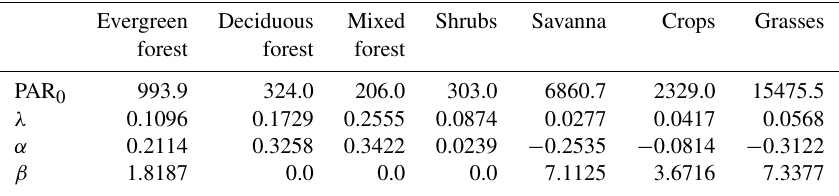
Table A1. VPRM parameters used within WRF-GHG. Evergreen Deciduous Mixed